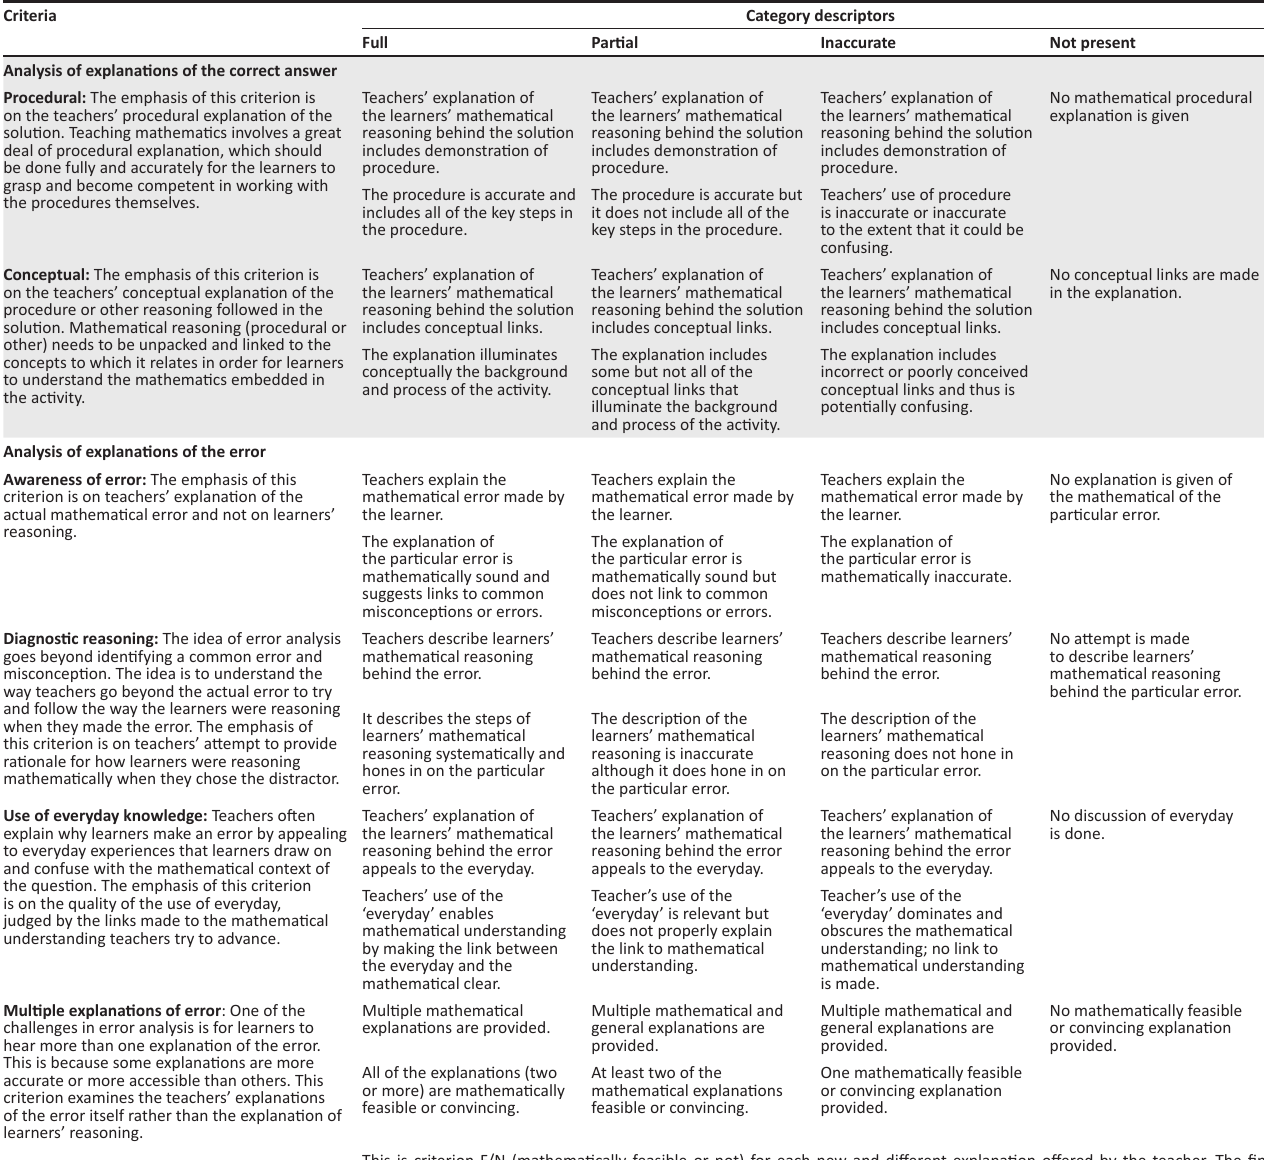
TABLE 1−A1: Error analysis coding